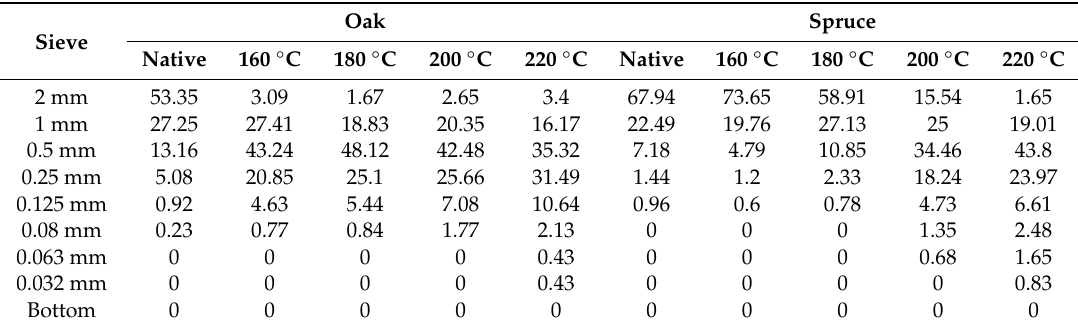
Table 2. Percentage of particles on individual mesh sieves in the case of both oak wood and spruce wood with feed rate v f = 10 m · min − 1 .